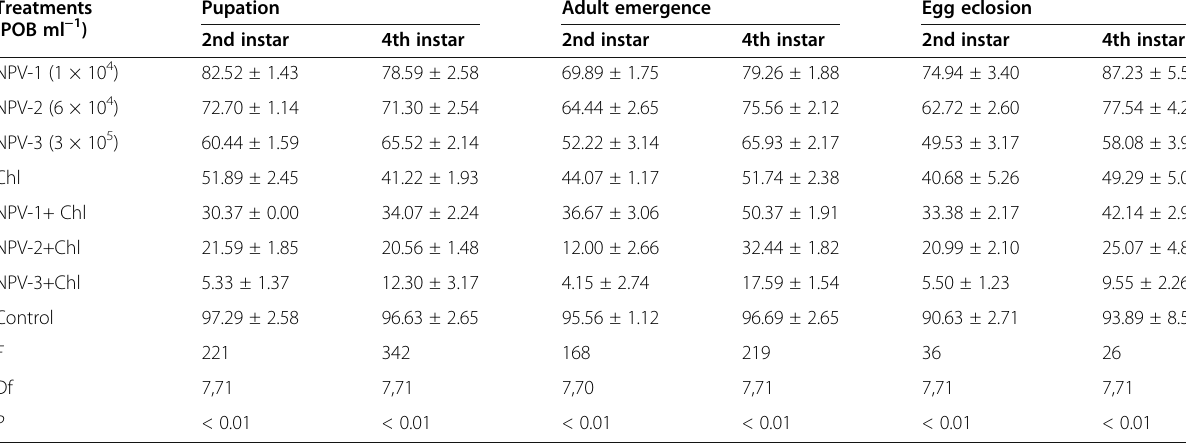
Table 4 The mean pupation, adult emergence, and egg eclosion (% ± SE) of the 2nd and 4th instars ( n = 20) of Spodoptera exigua larvae treated with nucleopolyhedrovirus alone and in combination with